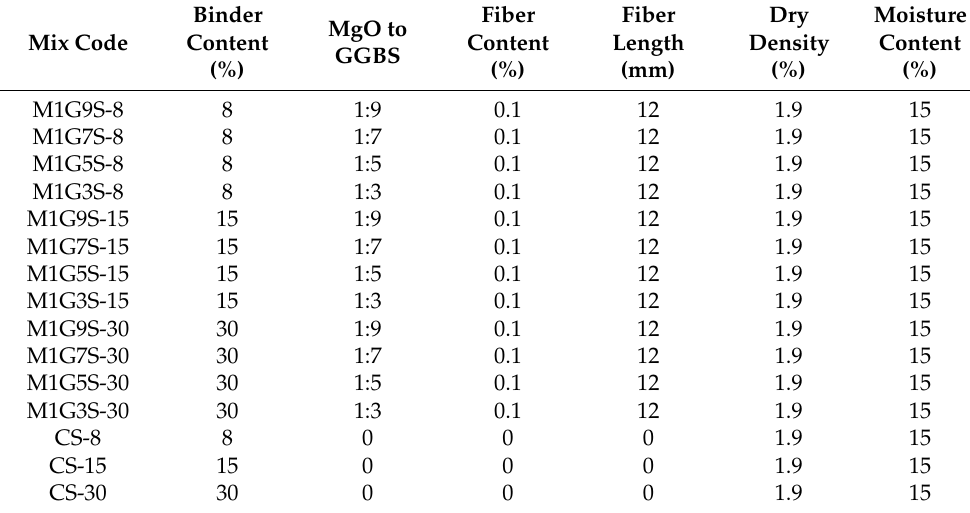
Table 5. Ratio design of MgO-activated GGBS-fiber-stabilized and cement-stabilized shield